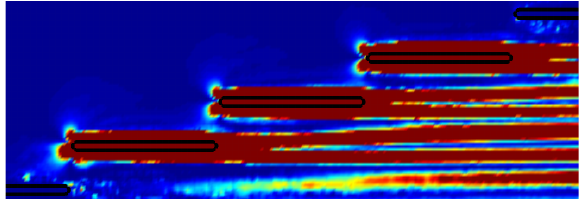
Fig. 10. Computed power spectral density of x -component of velocity Fig. 4. Detail of computational mesh in the vicinity of simplified cascade.